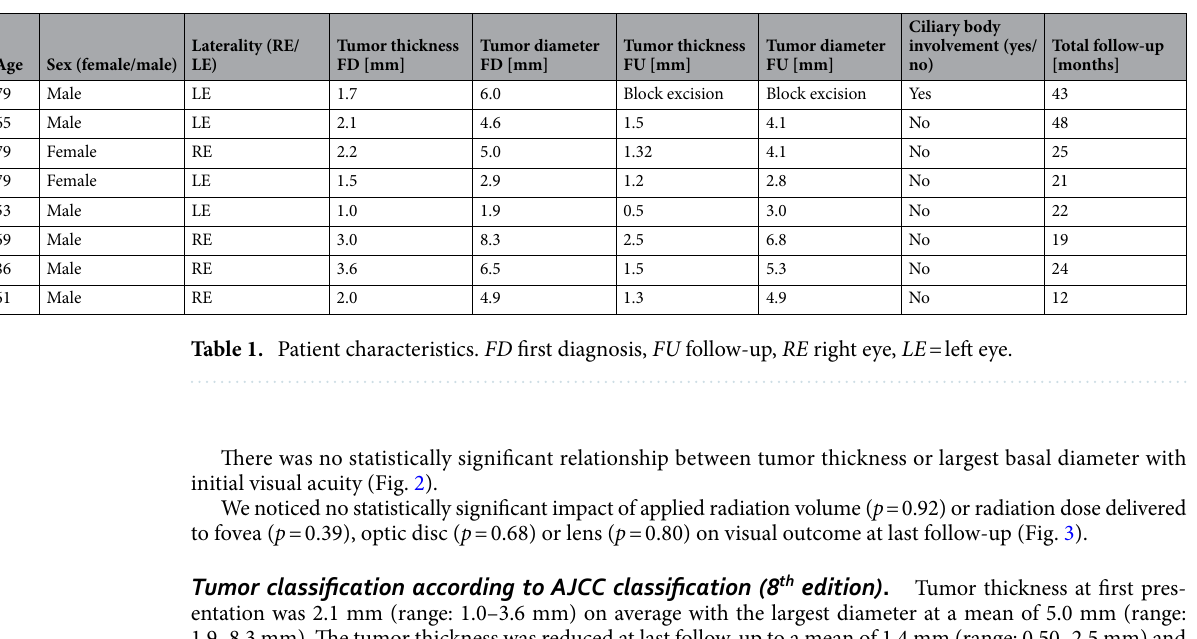
Treatment modalities. All patients were treated with 21 Gy at a 70% isodose. An inhomogeneous dose prescription is standard practice for all tumors treated with CyberKnife, and for most other radiosurgery tech- niques using small photon beams. An example of our treatment plan is shown in Fig. 4. Applied radiation vol-